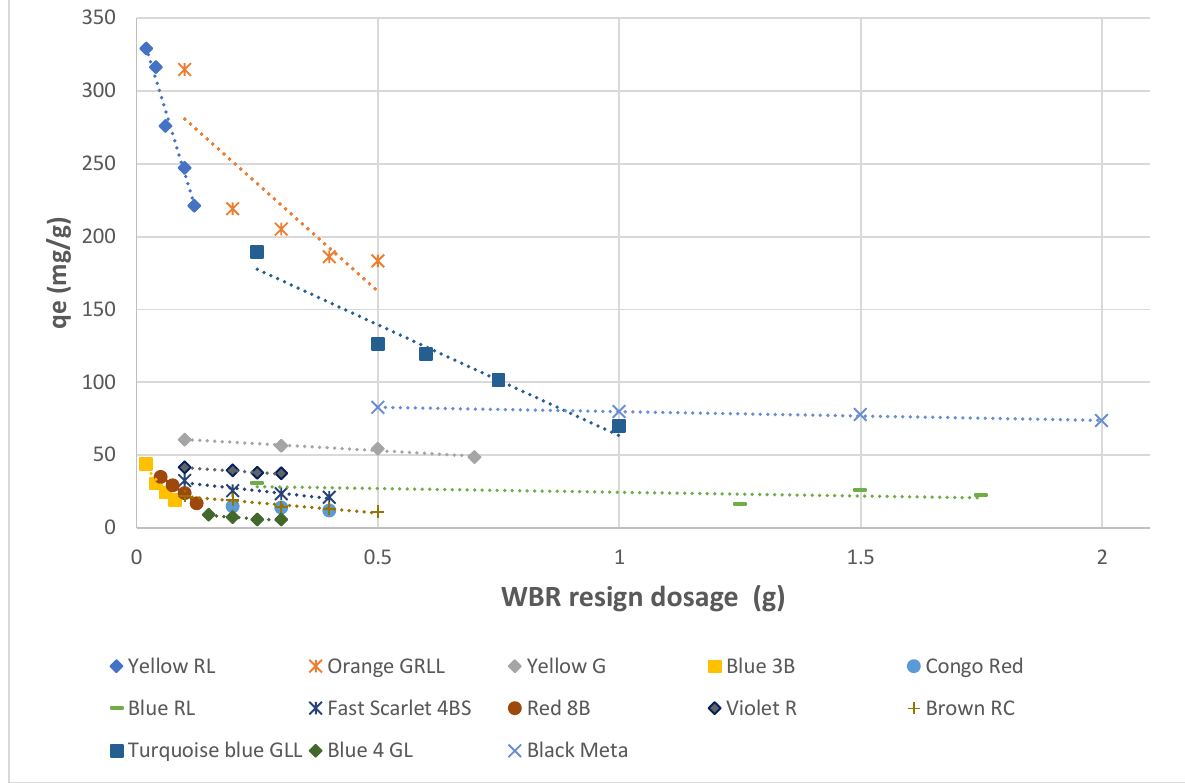
Figure 17. Impact of Amberlite IRA 67 resin quantity on the adsorption of direct dyes.